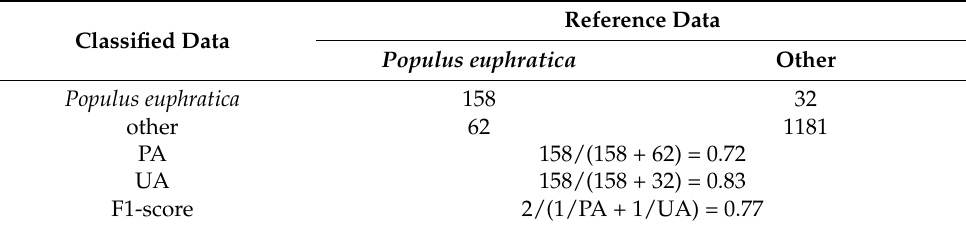
Table 6. Confusion matrix classification results using the combined IRECI index and maximum